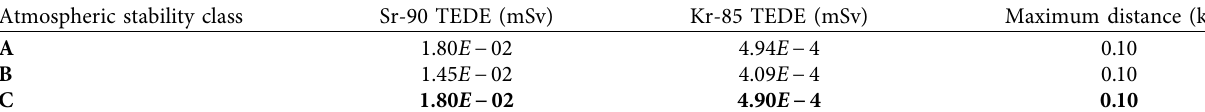
Table 4: Maximum TEDE values for some selected radionuclides at different atmospheric stability classes.